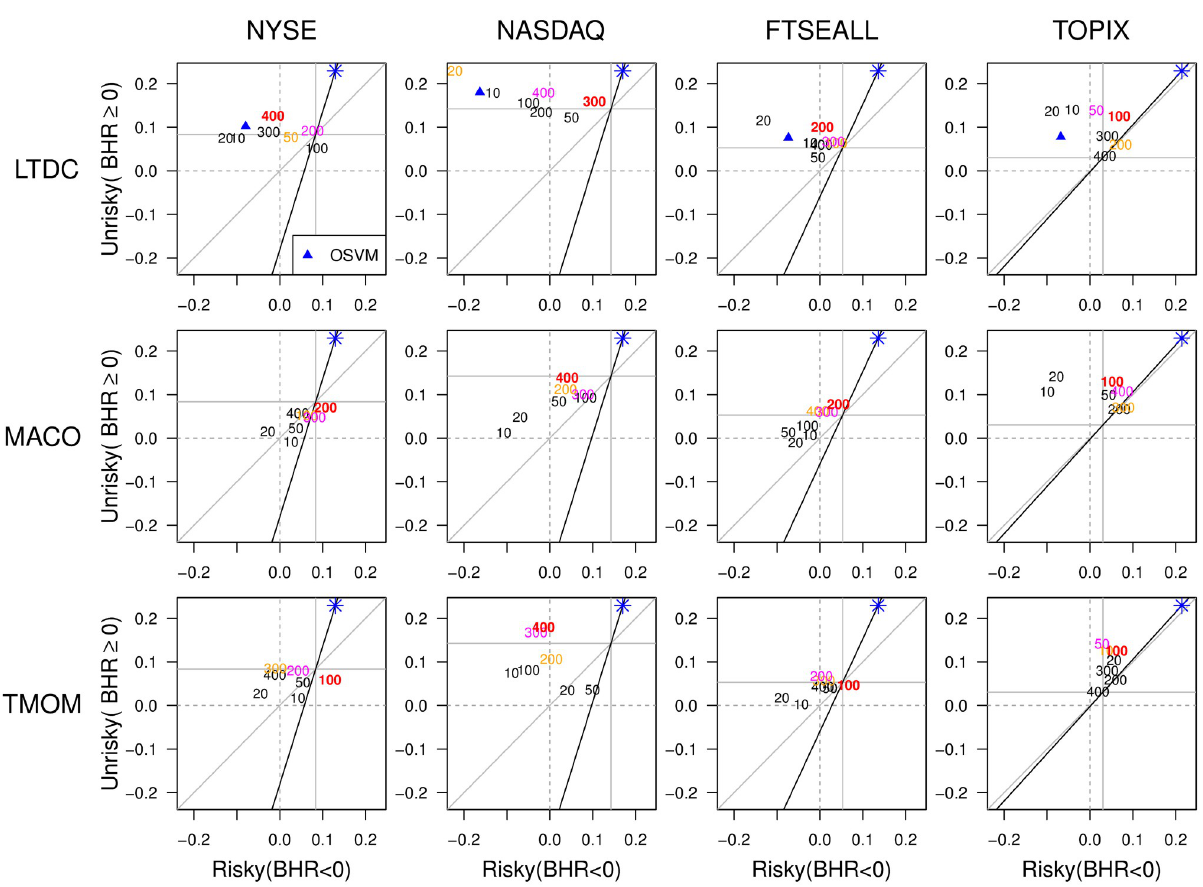
Fig 11. Averaging windows and the balance between positive and negative market directions. The red, pink, and orange figures are the first, second, and third profit-maximizing d L values, respectively. The blue star at the upper right end of the black upward-sloping line indicates the direction for maximizing profit while keeping the upward/downward ratio of the corresponding market.